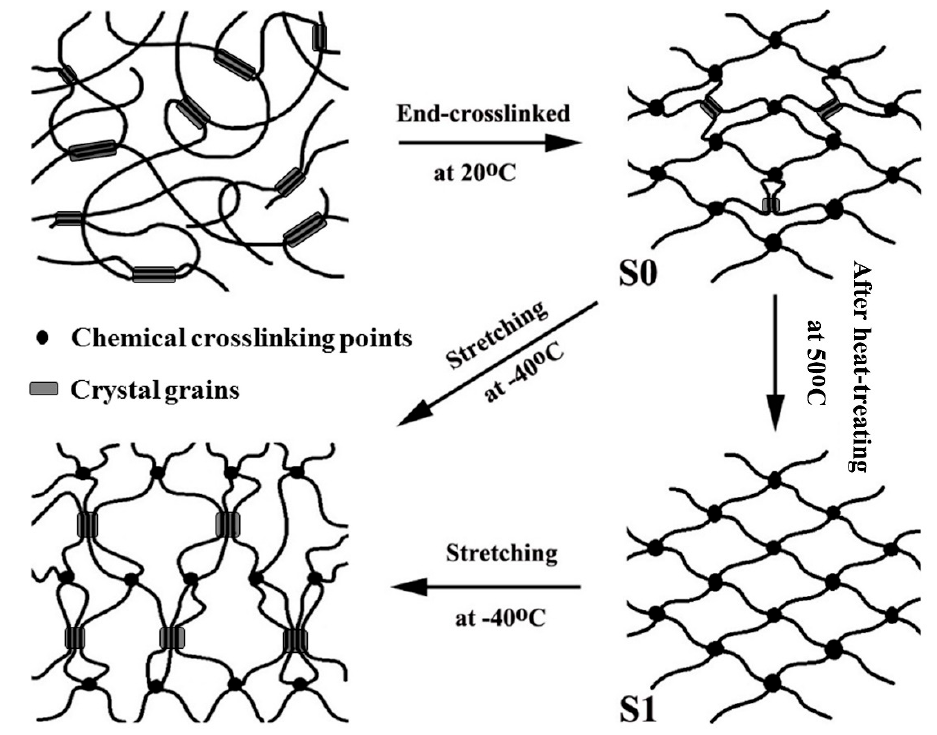
Figure 6. Schematic of the aggregation evolution for P(BAMO-r-THF)